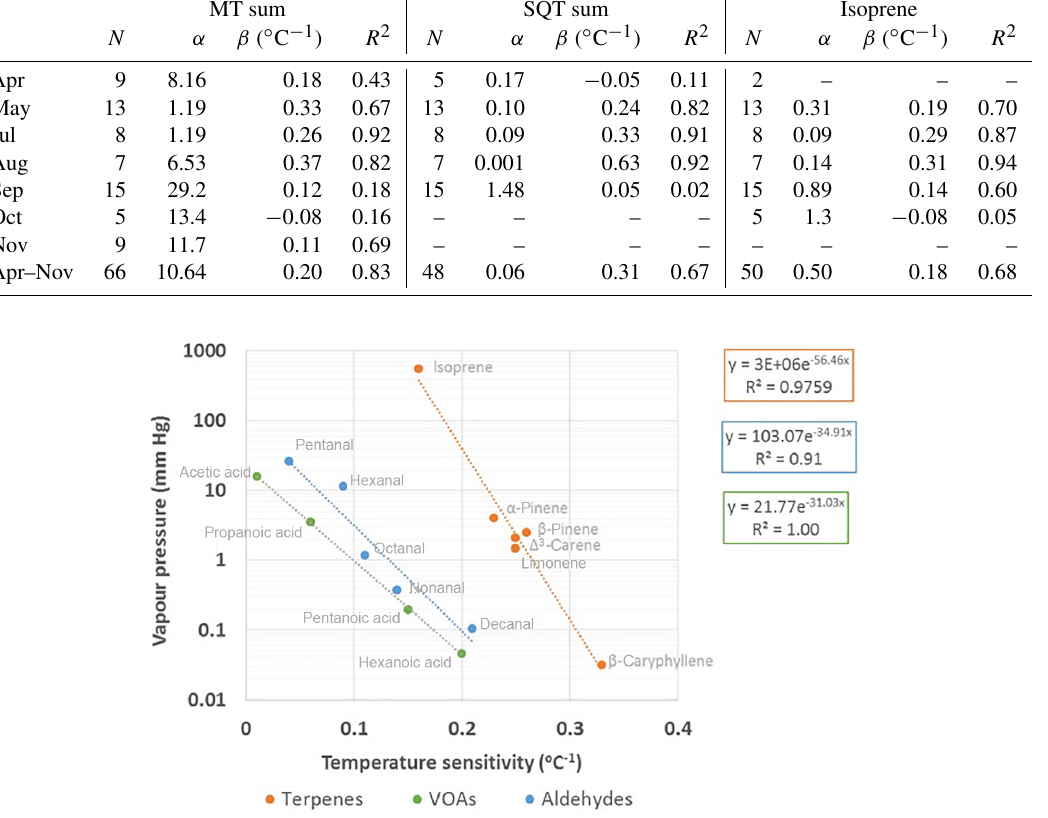
Figure 6. Vapour pressure dependence of temperature sensitivities β ( ◦ C − 1 ) of monthly mean concentrations measured at SMEAR II in 2016. Values for temperature sensitivities and exponent functions of temperature dependence of concentrations can be found in Table 3. Note that the y axis is in a logarithmic